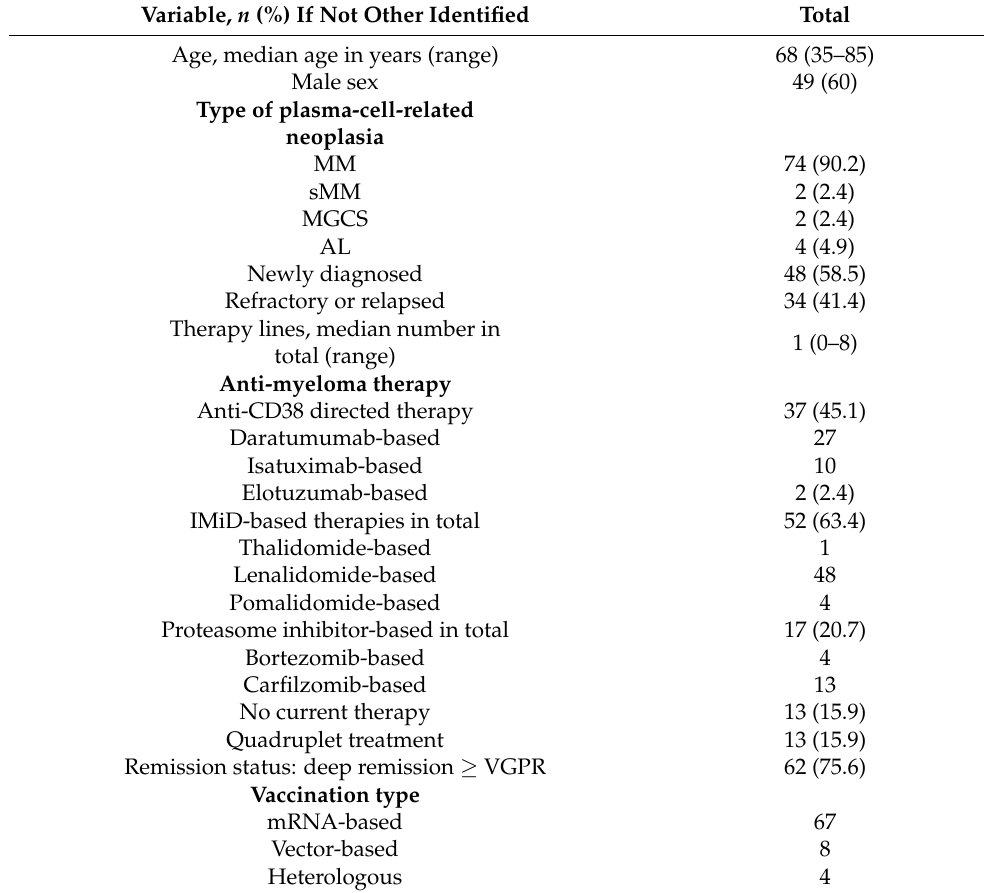
Table 1. Myeloma patients’ demographics and